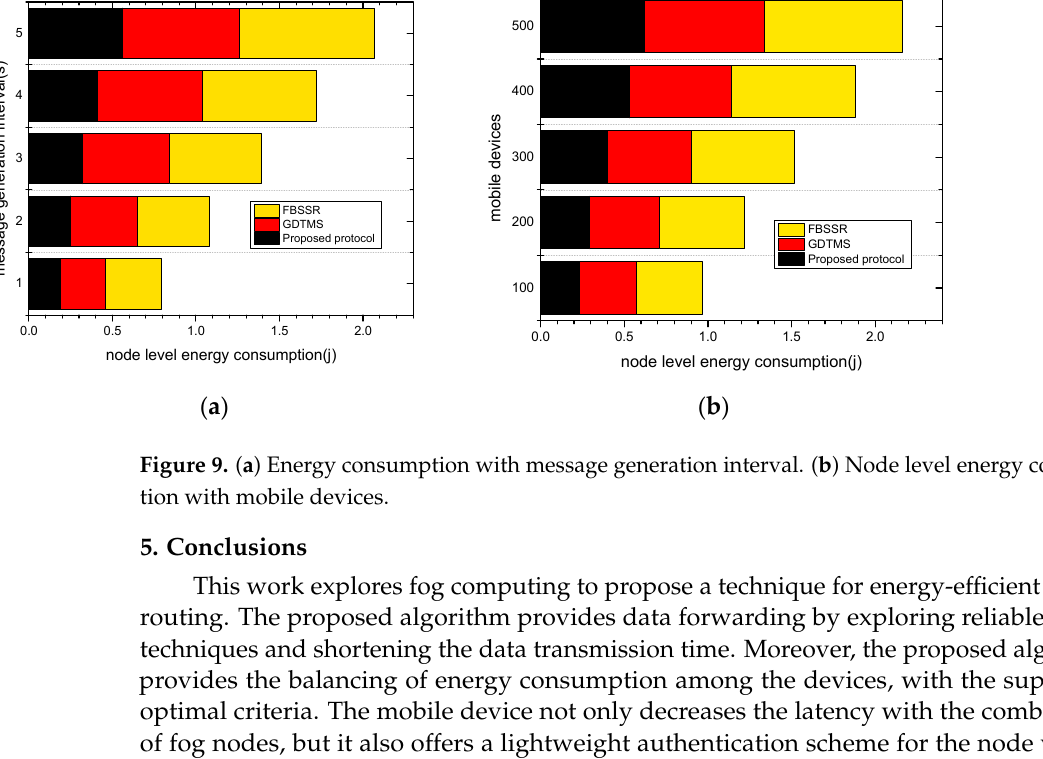
Figure 8. ( a ) Delay with varying time. ( b ) Number of packets with varying time.